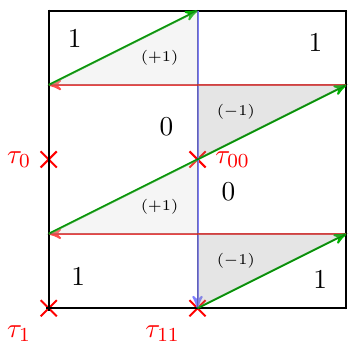
Figure 2b. The five-brane diagram of C 2 / Z 2 × C , with the four fixed points of the orientifold